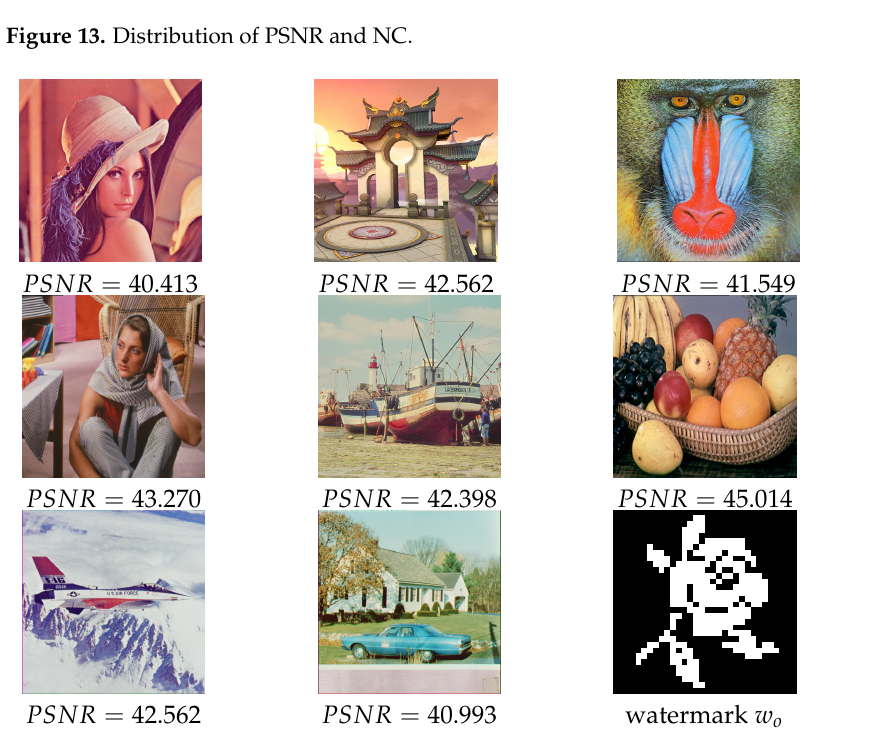
Figure 14. PSNR of watermarked images